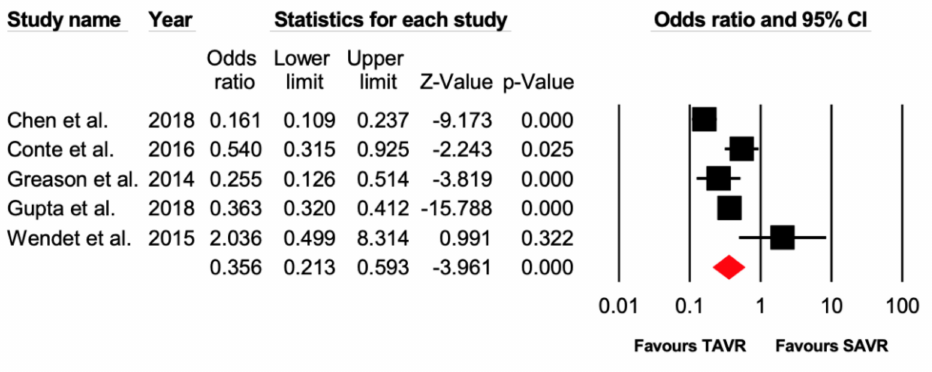
Figure 5. Forest plot comparing the risk of post-operative bleeding between transcatheter versus surgical aortic valve